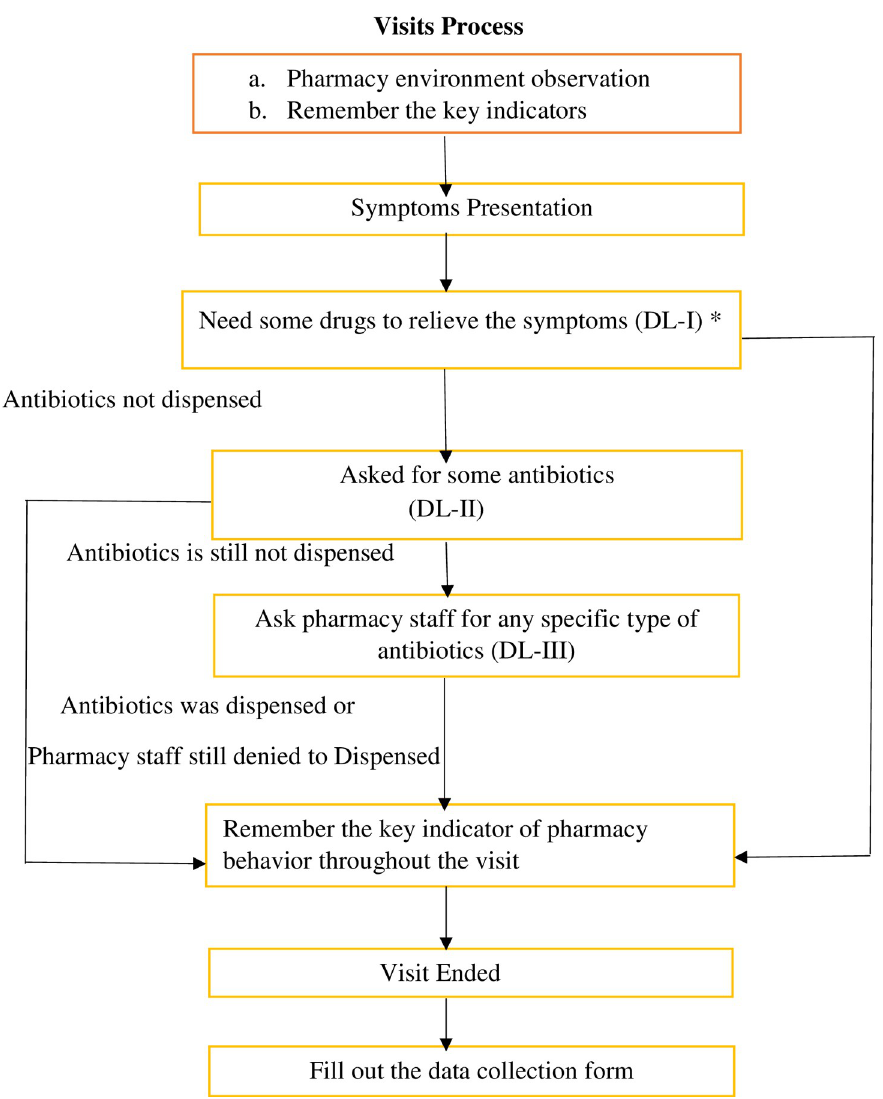
Fig 1. Data collection process: Key indicators involve name, professional license, the appearance of the dispenser, key indicators for dispensing, dispensed antibiotics name and dose, demand level and any alternative medication offers. � DL = Demand